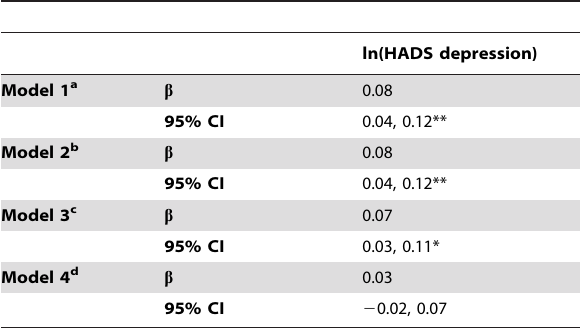
Table 4. Multivariate associations between NT-proBNP and depression